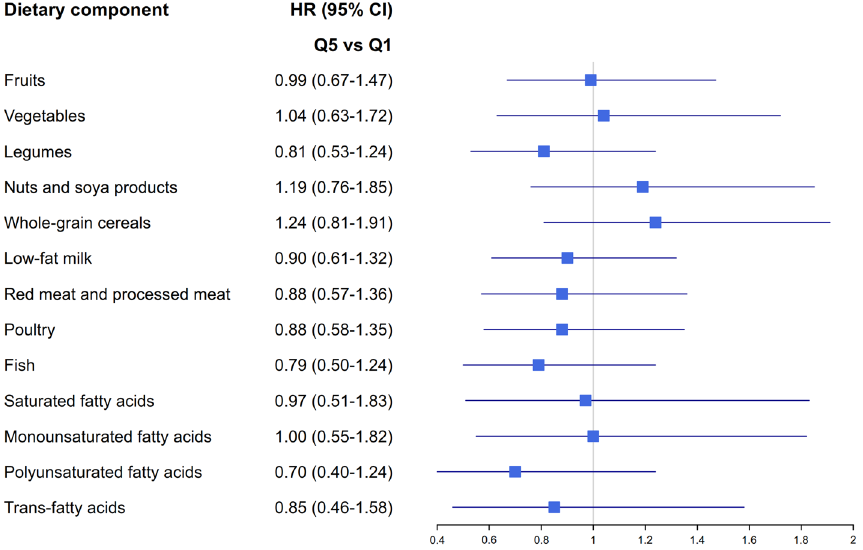
Figure 1. Multivariable hazard ratios (HR) and confidence intervals (95% CI) of postmenopausal breast cancer by highest (Q5) and lowest (Q1) of specific dietary index